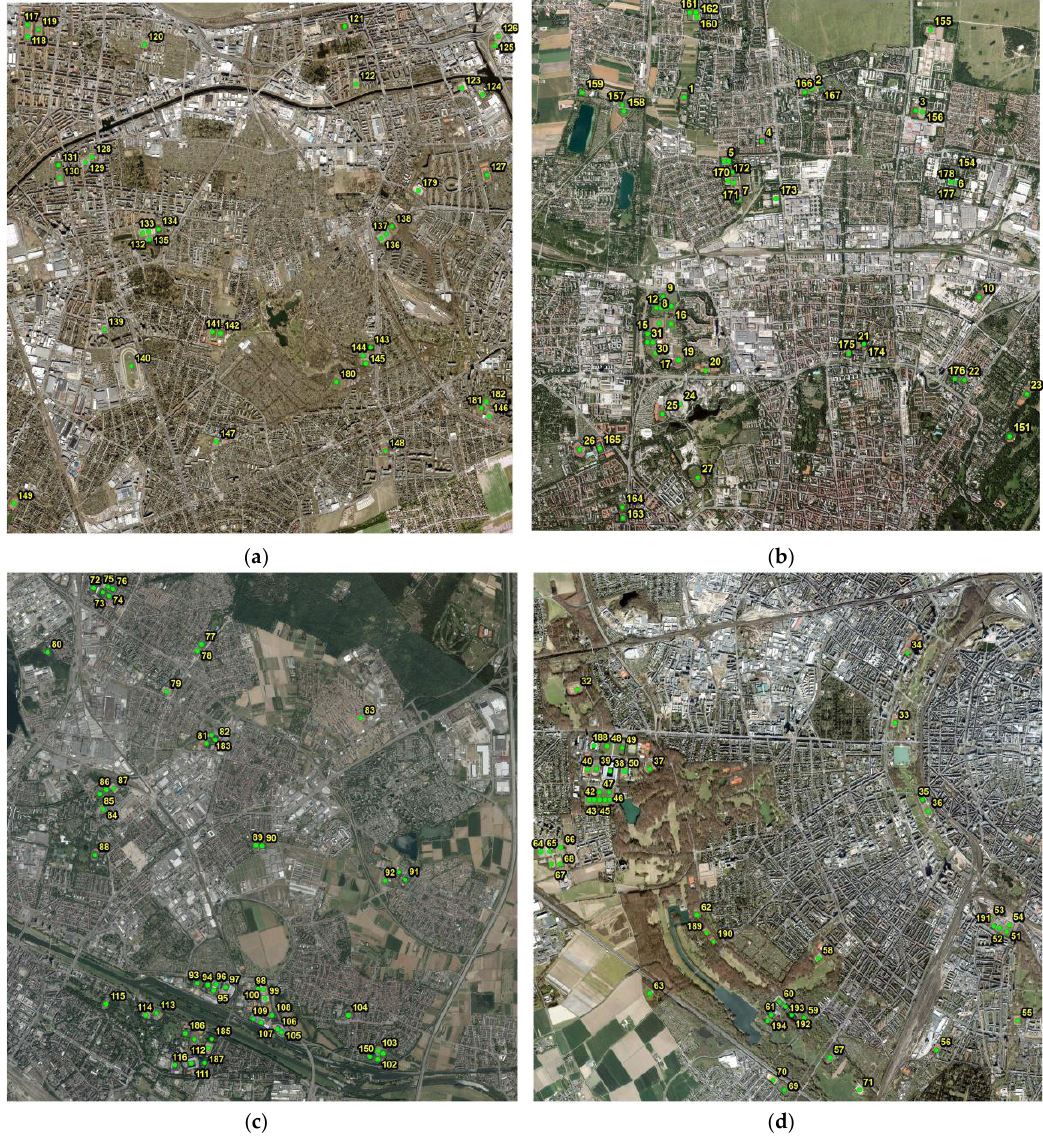
Figure 5. Inference areas and ground truth for ( a ) Berlin; ( b ) Munich; ( c ) Mannheim; ( d ) Cologne.